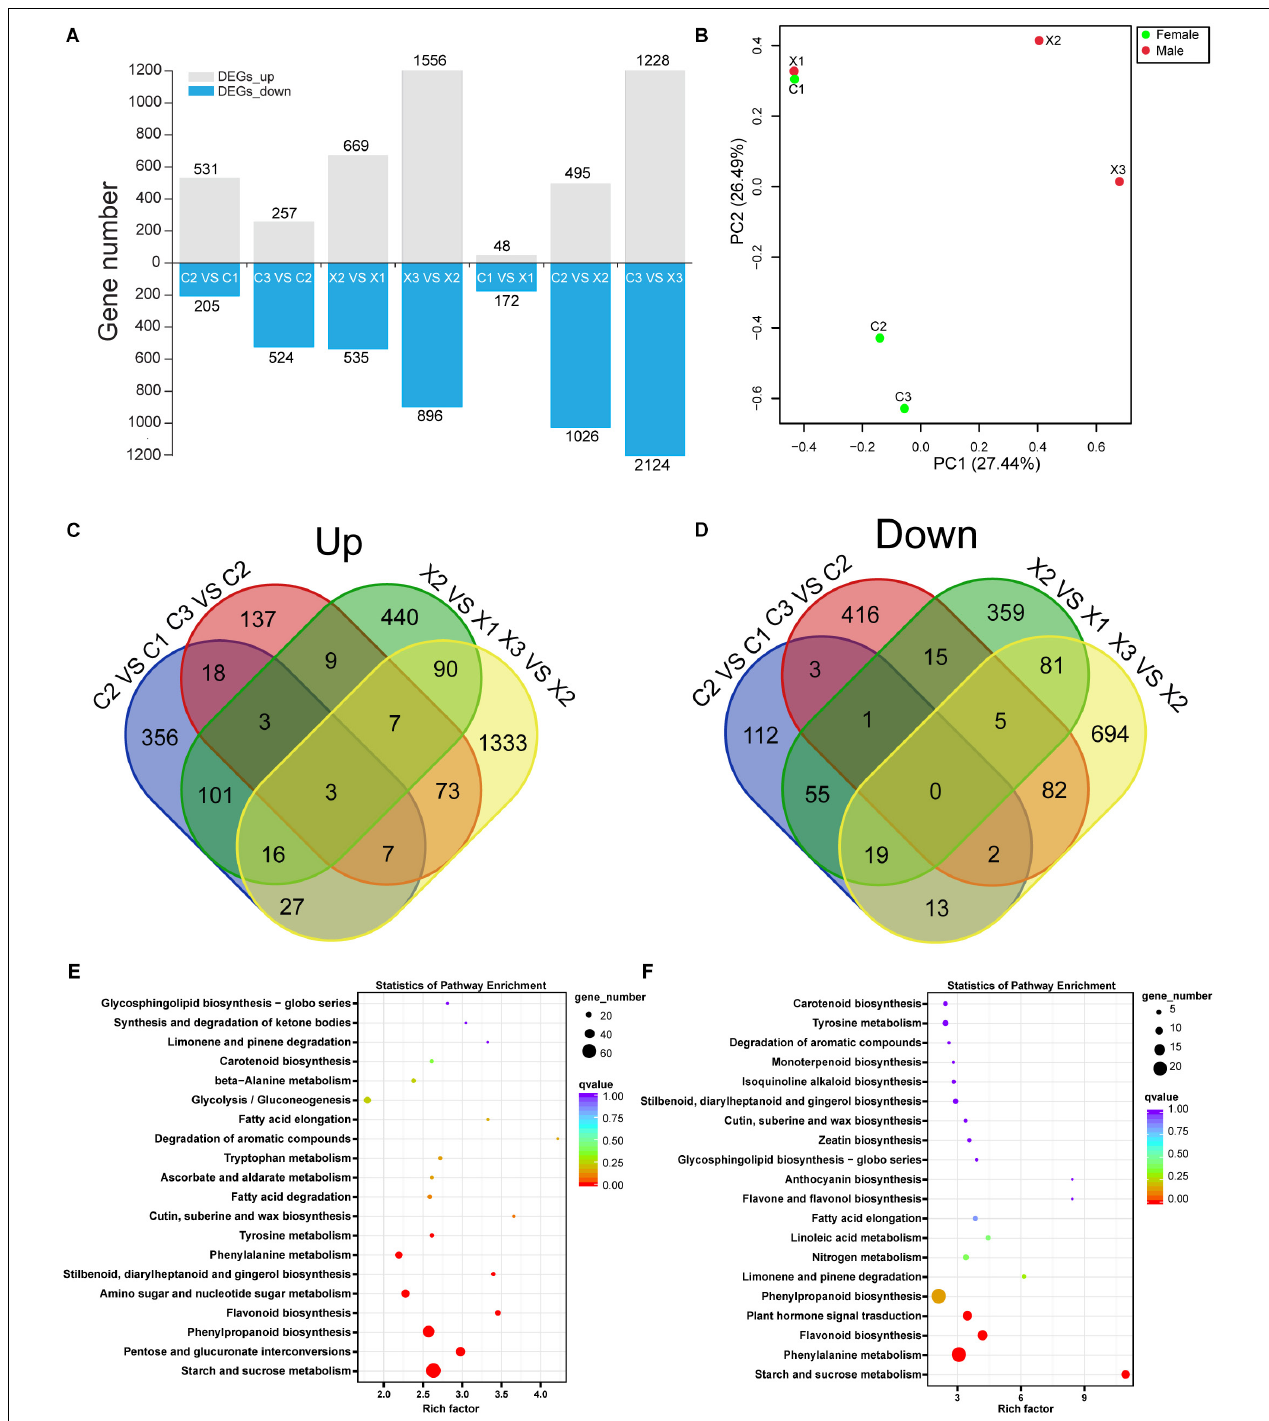
FIGURE 2 | Analysis of DEGs in male and female flowers. (A) Numbers of DEGs in male and female flowers. (B) PCA plot of DEGs in male and female flowers. (C,D) Venn diagrams of the up-regulated and down-regulated DEGs in male and female flowers. (E,F) KEGG enrichment of DEGs in male and female flowers.